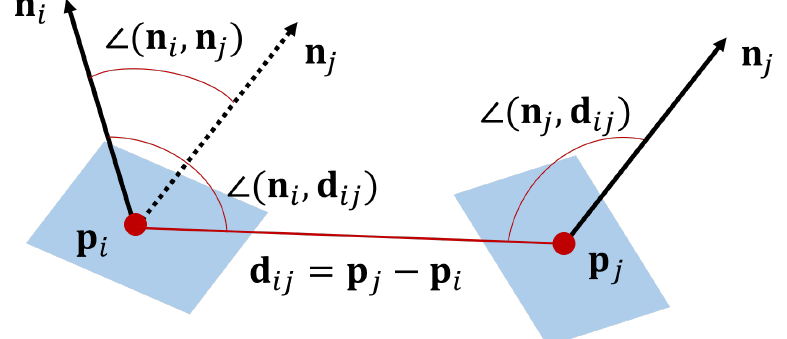
Figure 11. Illustration of Point Pair Feature